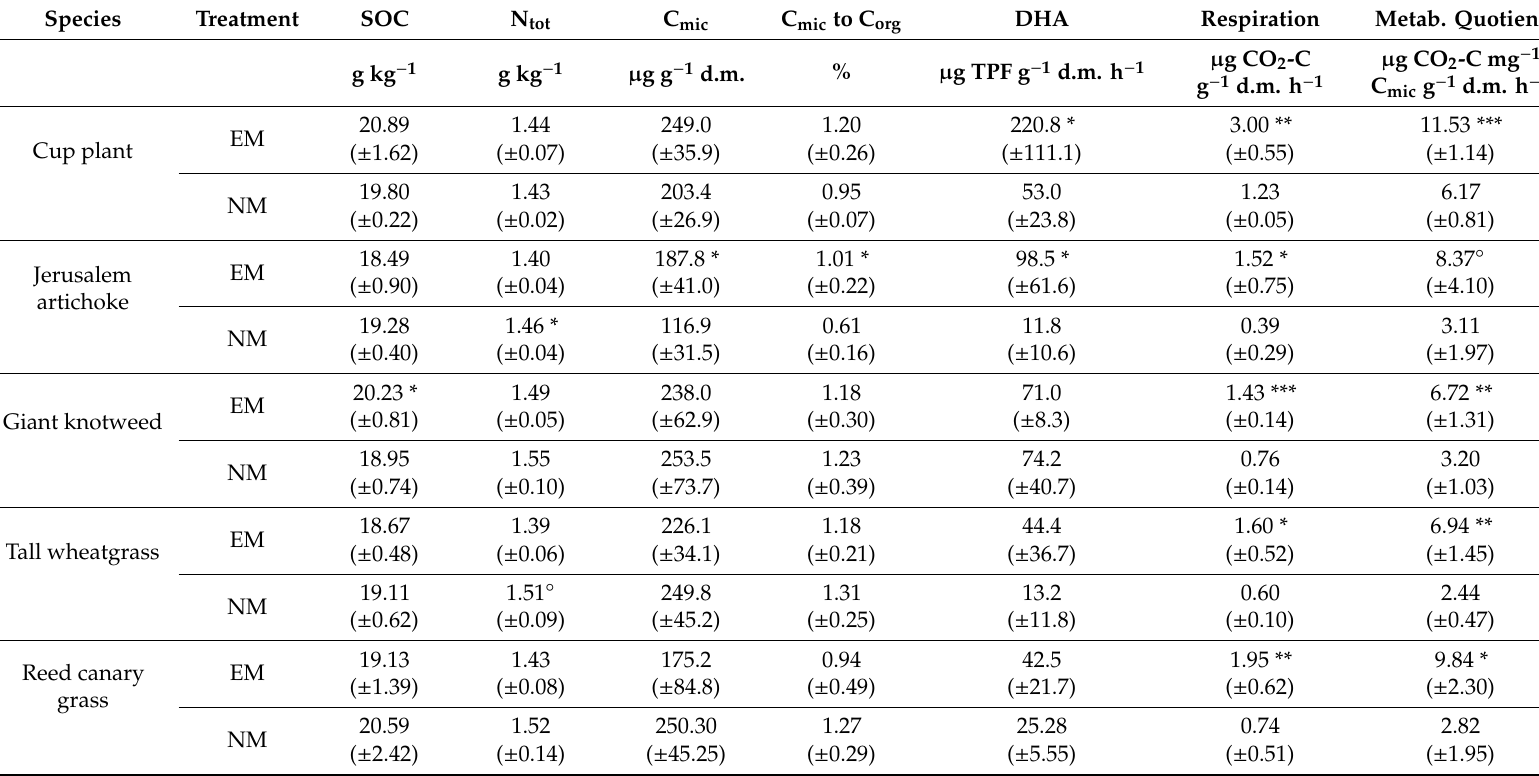
Table 5. Soil chemical and microbial parameters (mean values ± standard deviation, n = 5). Amounts of soil microbial biomass (C mic ), dehydrogenase activity (DHA) and soil respiration were measured at given soil water contents without any pretreatment in order not to modify the conditions present in the soil. Significant di ff erences between both soil moisture treatments (‘EM’: excess soil moisture, ‘NM’: non-excess soil moisture) of a certain species are indicated as follows: ◦ : <